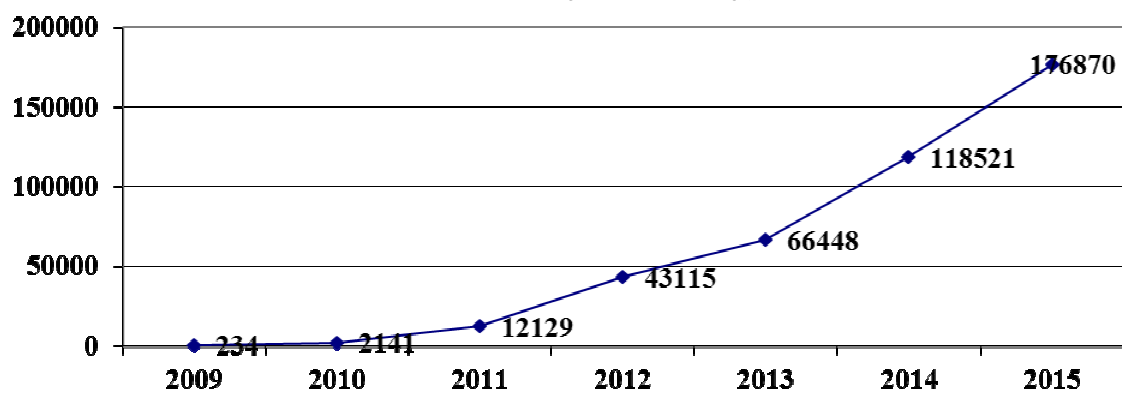
Figure 2: Private Accommodation Offered by Airbnb (Italy, 2009-2015)